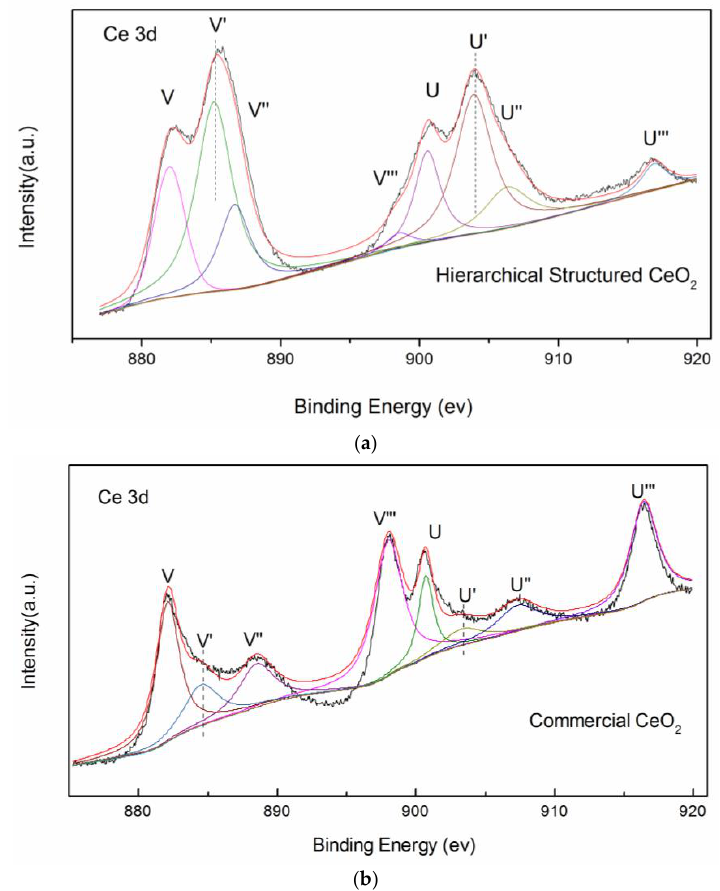
Figure 7. X-ray photoelectron spectra of Ce 3D regions of 3D ( a ) hierarchical structured CeO 2 and ( b ) commercial CeO 2 .